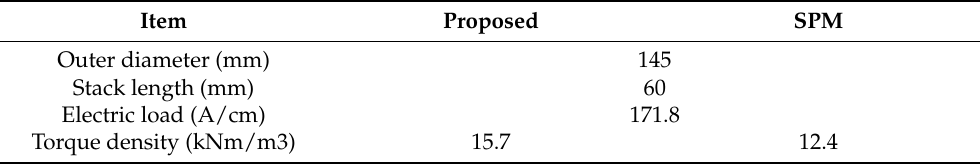
Table 2. Torque density comparison of two machines.